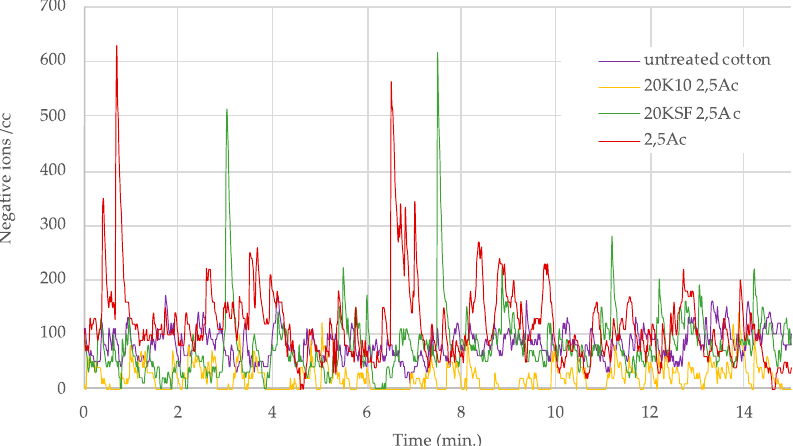
Figure 5. Negative ions/cc in 15 min released by treated samples with 2.5 g/L of acrylic binder.